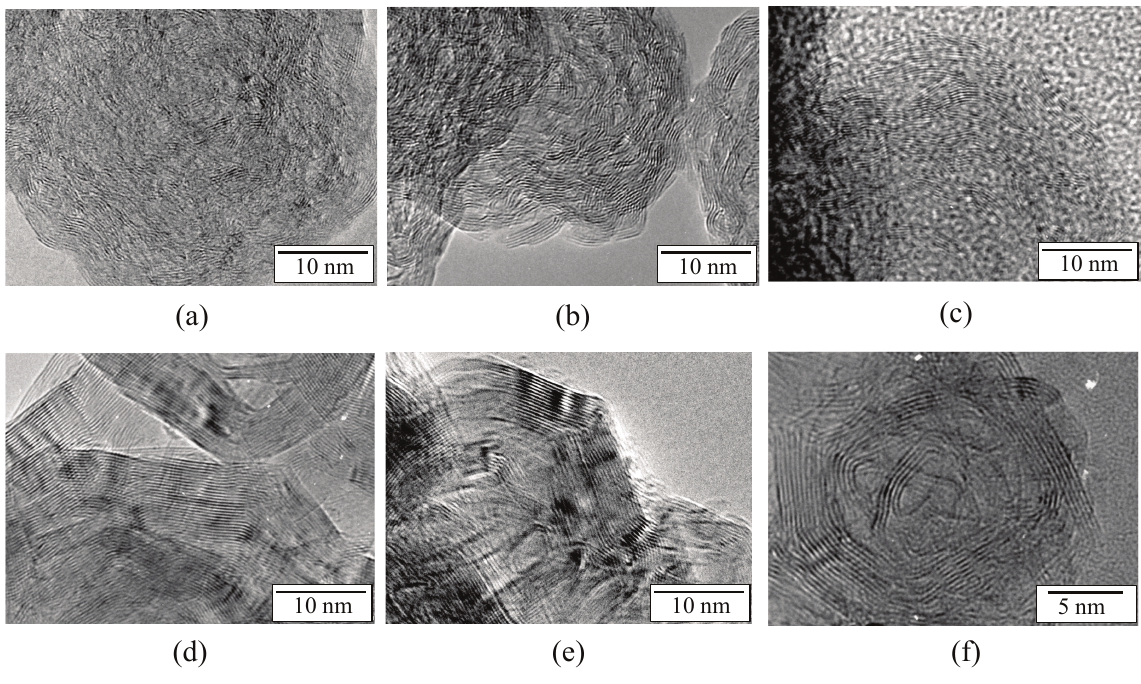
Figure 5. HRTEM images of the samples annealed at ( a ) 1450 °C; ( b ) 1600 °C; ( c ) 1700 °C; ( d ) 1800 °C; ( e ) 2000 °C; ( f ) evidence of a core-shell structure generated at 2000